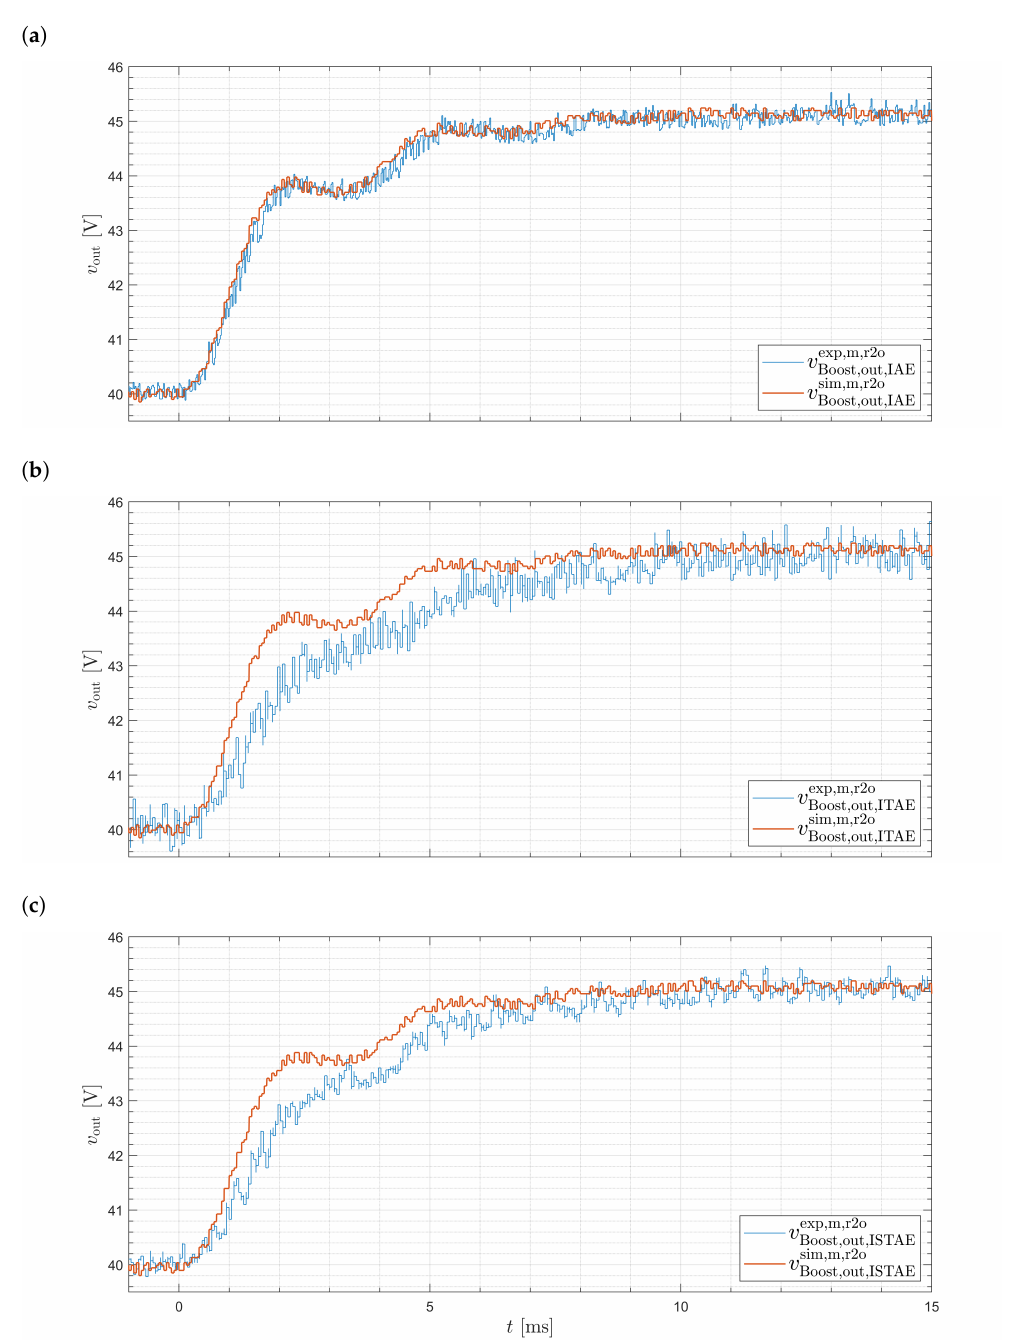
Figure 11. Experimental and simulated reference-to-output step responses of the Boost converter output voltage, v exp,m,r2o and v sim,m,r2o respectively, for different K P and K I compensator gains, Boost,out,.. Boost,out,.. see Table 6. The gains have been selected by means of GA constrained with GM = (cid:104) 10,20 (cid:105) dB and PM = (cid:104) 80,90 (cid:105) °, basing on three different fitness functions: ( a ) IAE according to Equation (26); ( b ) ITAE according to Equation (27); ( c ) ISTAE according to Equation